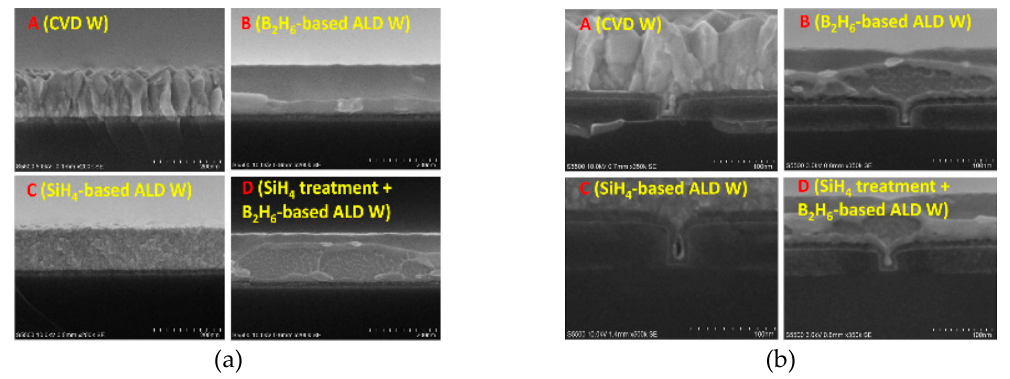
Figure 14. Cross-sectional SEM images of W films grown in different conditions: ( a ) on blank wafers and ( b ) trenches filling capacity [104].